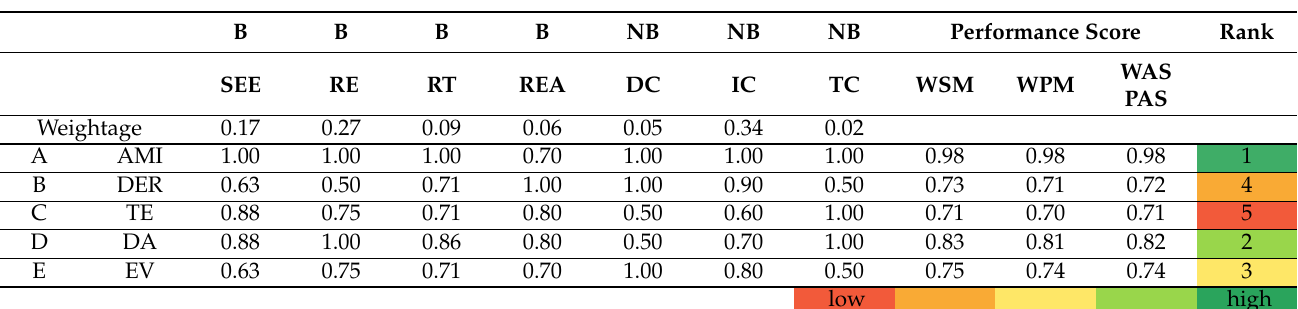
Table 21. MCDM operation with the Enhanced-accuracy-Normalization. B ≡ Beneficial, NB ≡ Non-Beneficial. SEE ≡ System Efficiency Enhancement, RE ≡ Reliability Enhancement, RT ≡ Reduced Theft, REA ≡ Renewable Energy Adoption, DC ≡ Deployment Challenges, IC ≡ Investment Cost, TC ≡ Technological Challenges. The Enhanced-accuracy-Normalization formula for NB: EN ( x ij ) NB = 1 −